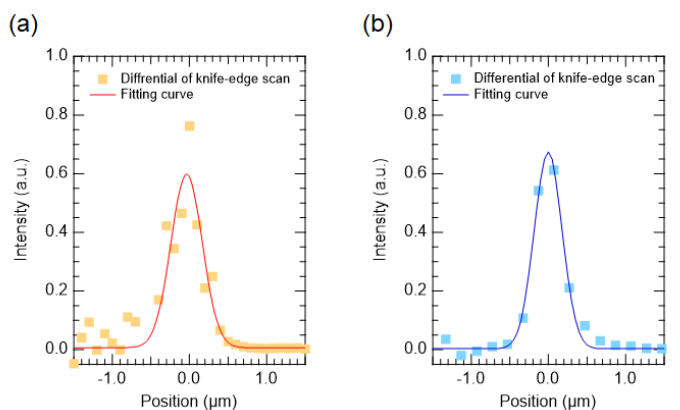
Figure 1. Intensity profiles of focused X-ray free electron laser (XFEL) pulses in ( a ) vertical direction and ( b ) horizontal direction. Focal spot sizes, which are derived from Gaussian fitting of differential knife-edge scan results, are ( a ) 480 nm and ( b ) 430 nm, respectively.